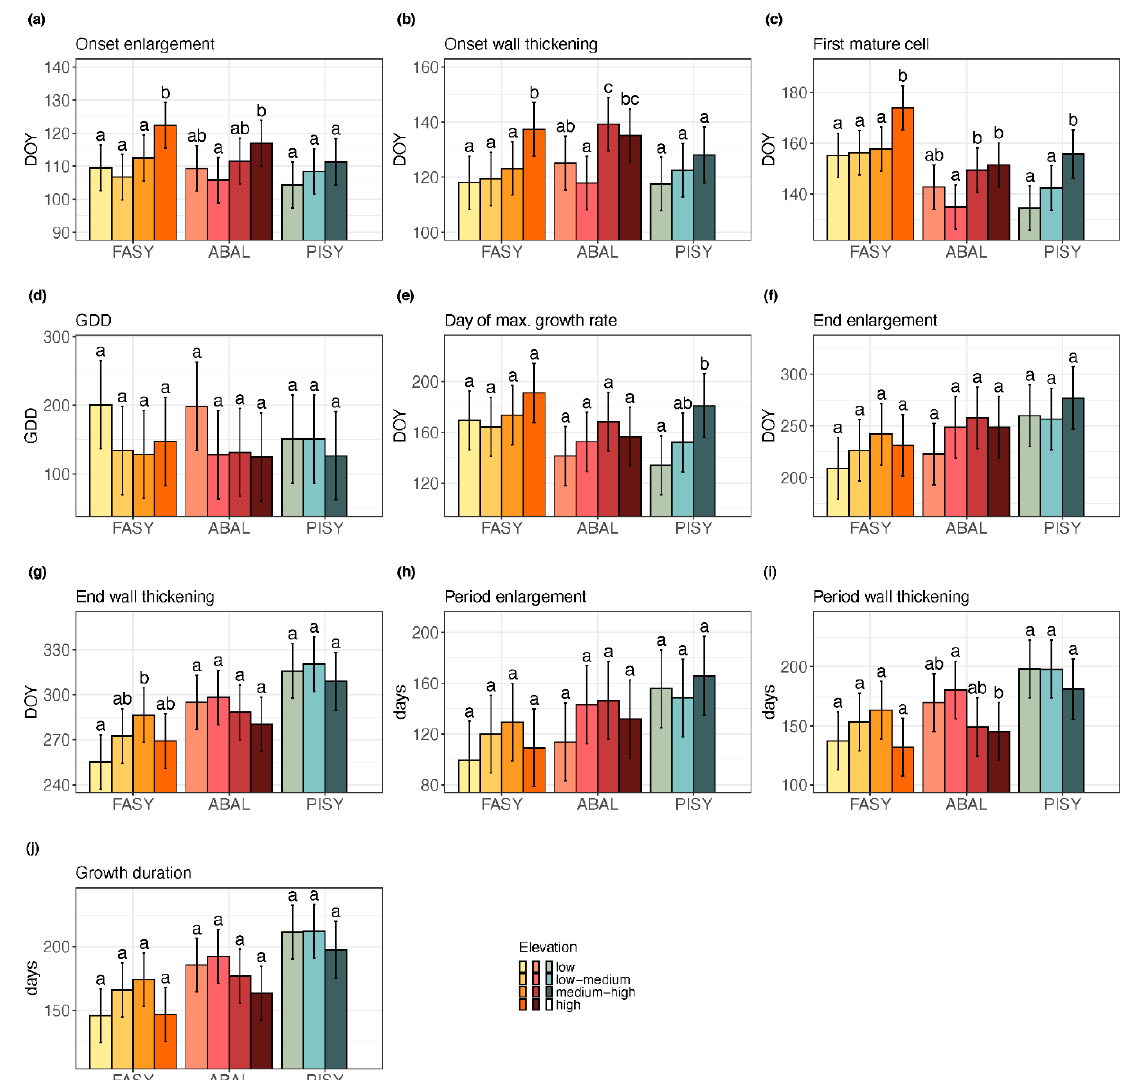
Figure 5. Estimated marginal means of the xylem phenology by elevation and tree species (onset enlargement ( a ), onset secondary cell wall thickening ( b ), onset maturation ( c ), growing degree days ( d ), the day of the maximum daily growth rate ( e ), cessation of enlargement ( f ), cessation of secondary wall thickening ( g ), the period of enlargement ( h ), the period of secondary wall thickening ( i ) and the overall growth duration ( j ); FASY: Fagus sylvatica , ABAL: Abies alba , PISY: Pinus sylvestris ). Error bars indicate 95% confidence levels of estimated marginal means. Different lowercase letters indicate significant differences of the sample means between elevations within each tree species ( p < 0.05).